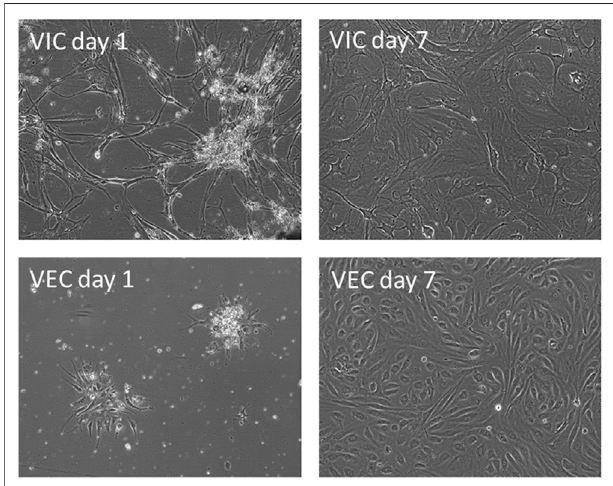
FIGURE 1 | Interstitial (VIC) and endothelial (VEC) cells isolated from human aortic valves shown on fi rst and seventh days after isolation. Phase contrast